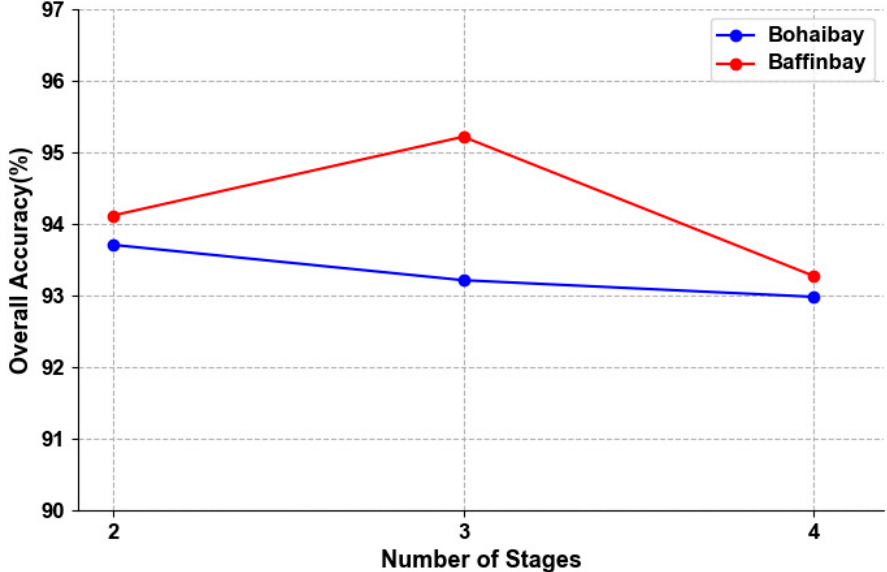
Figure 7. The influence of different network layers on the classification accuracy.